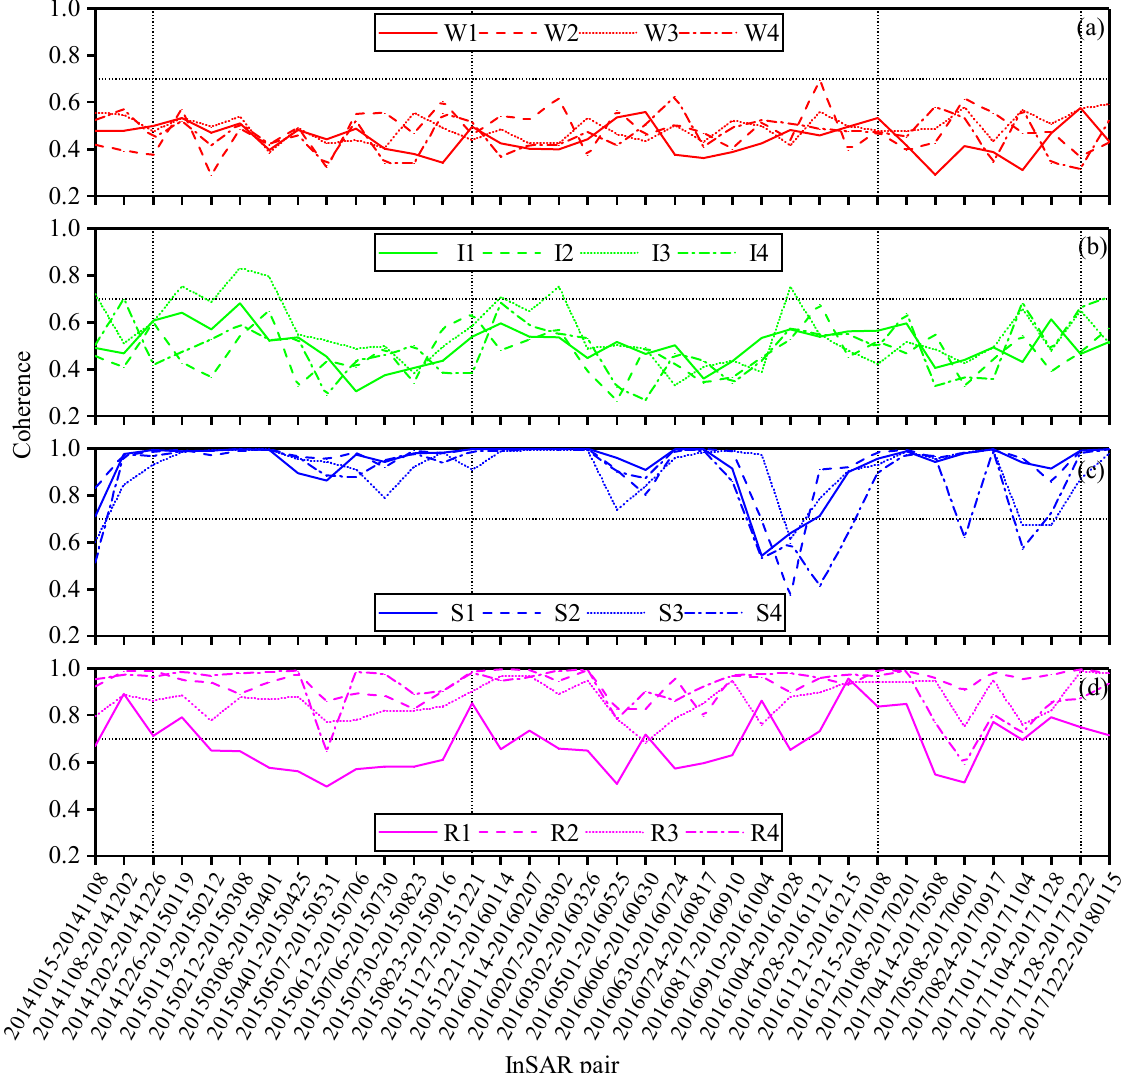
Figure 7. The coherence mean time series calculated with the 36 InSAR pairs for all the exemplified patches related to the wet snow, ice, soil land and river outwash, respectively. ( a ) shows the four curves of the coherence mean time series for four patches (W1 − W4), respectively, of the wet snow class, while ( b – d ) show those for the ice class (I1 − I4), the soil land class (S1 − S4) and the river outwash class (R1 − R4), respectively.